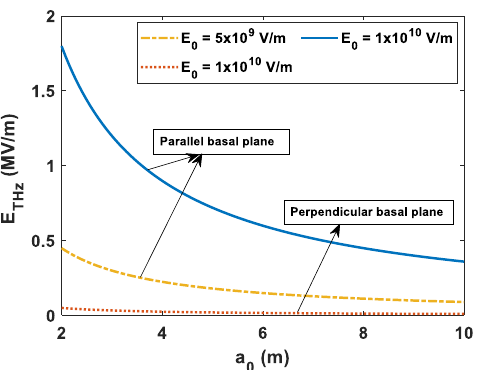
Figure 5. Variation of emitted THz radiation field with the beam width for different values of incident lasers field, when y = 0.95 𝑎 0 , 𝜔 ′ = 1.884 × 10 14 rad/s, 𝜔 ′′ = 1.811 × 10 14 rad/s, ℎ 𝑛𝑐 = 5𝑟 𝑛𝑐 and 𝑑 𝑛𝑐 = 6𝑟 𝑛𝑐 of the nanocylinders.